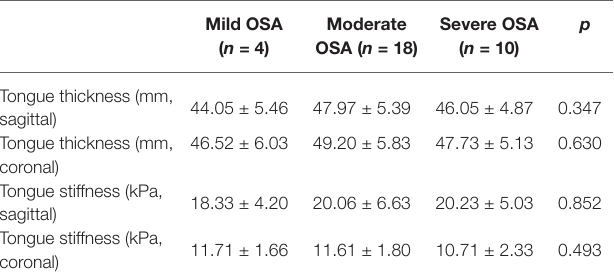
TABLE 5 | Associations between disease severity and ultrasound measurements in patients with obstructive sleep apnea